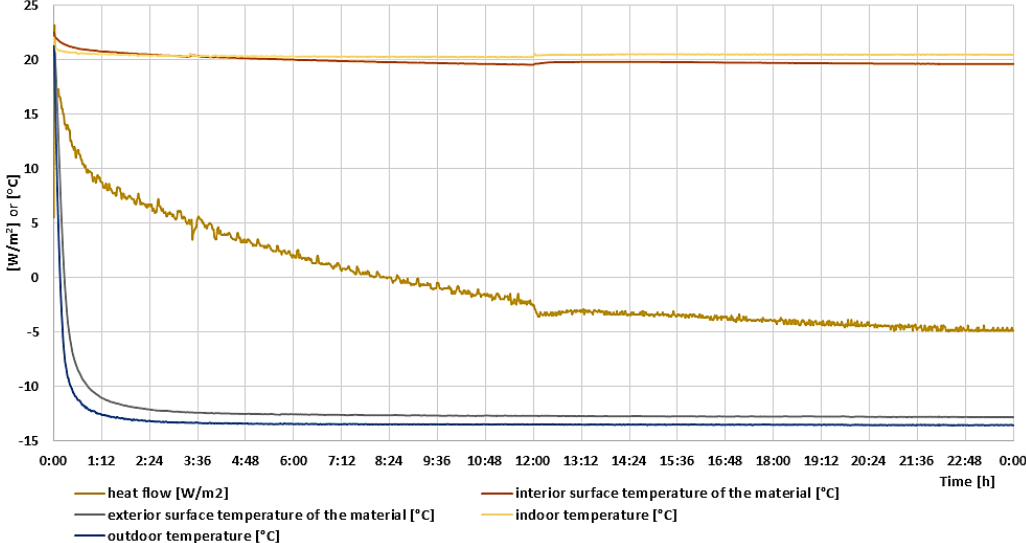
Figure 2. Development of the measured parameters during simulations—variant A.